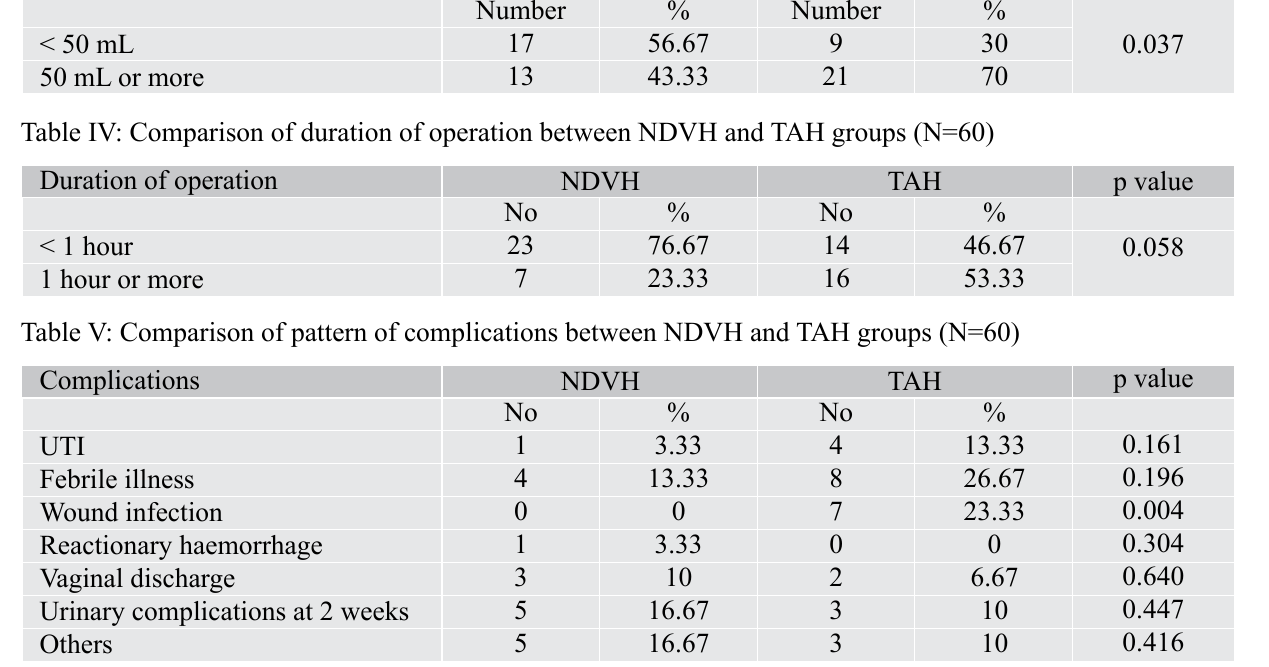
Table VI: Comparison of number of patients with complications between NDVH and TAH groups Complications